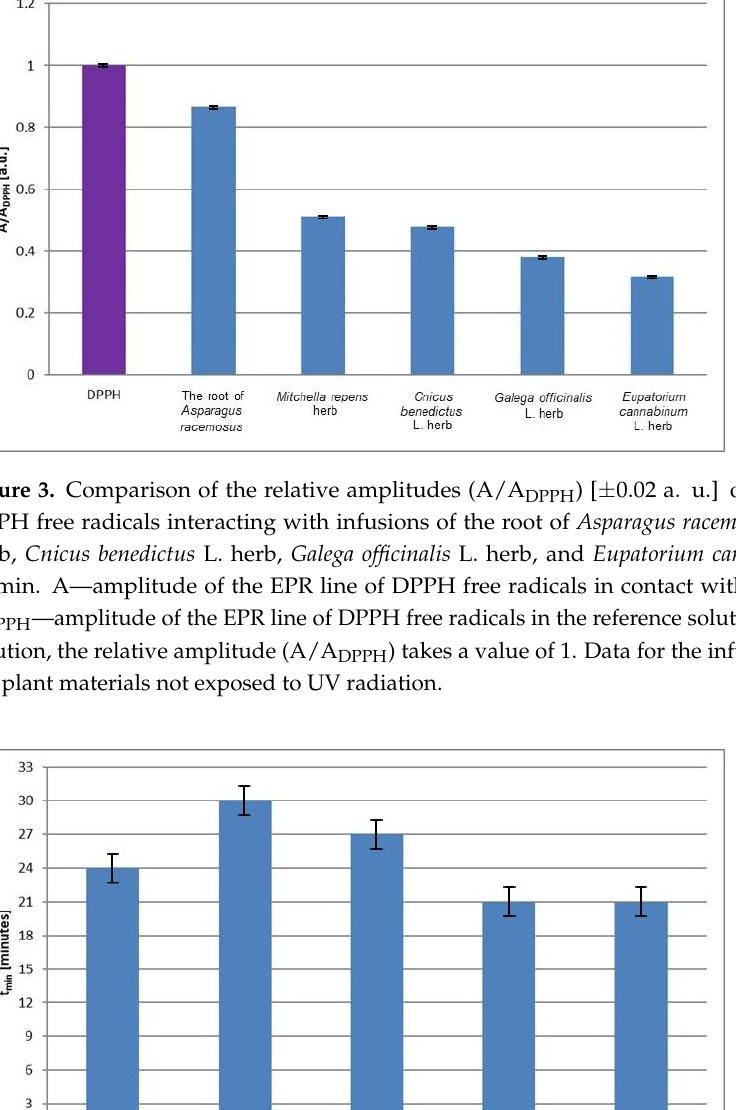
Figure 3. Comparison of the relative amplitudes (A/A DPPH ) [±0.02 a. u.] of the EPR spectra of DPPH free radicals interacting with infusions of the root of Asparagus racemosus , Mitchella repens herb, Cnicus benedictus L. herb, Galega officinalis L. herb, and Eupatorium cannabinum L. herb for 33 min. A—amplitude of the EPR line of DPPH free radicals in contact with the tested infusion. A DPPH — amplitude of the EPR line of DPPH free radicals in the reference solution. For the reference solution, the relative amplitude (A/A DPPH ) takes a value of 1. Data for the infusions obtained from the plant materials not exposed to UV radiation.